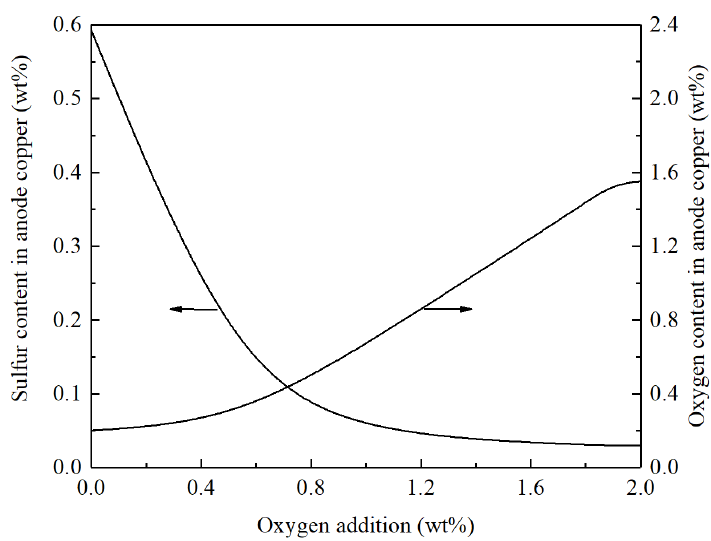
Figure 6. Effect of O 2 /blister on sulfur and oxygen contents in anode copper at 1200 ◦ C.